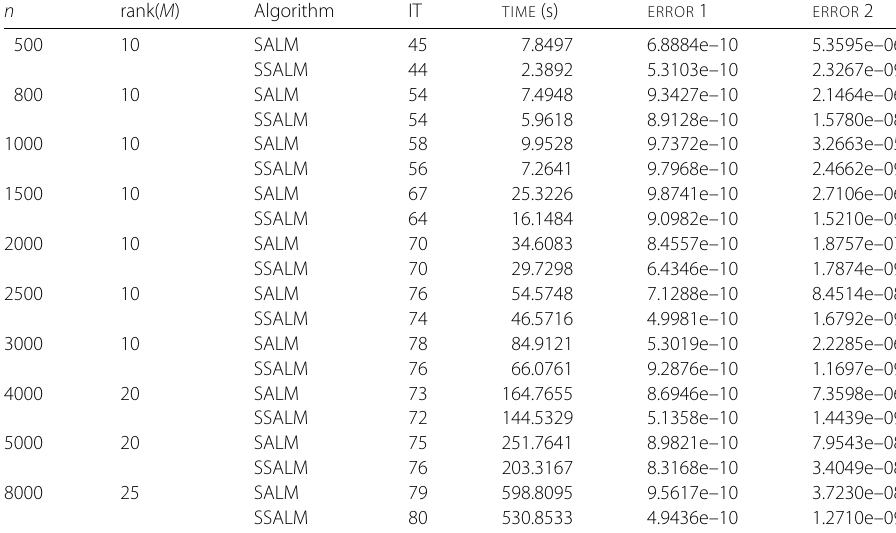
Table 3 Comparison between SALM and SSALM for p = 0.4